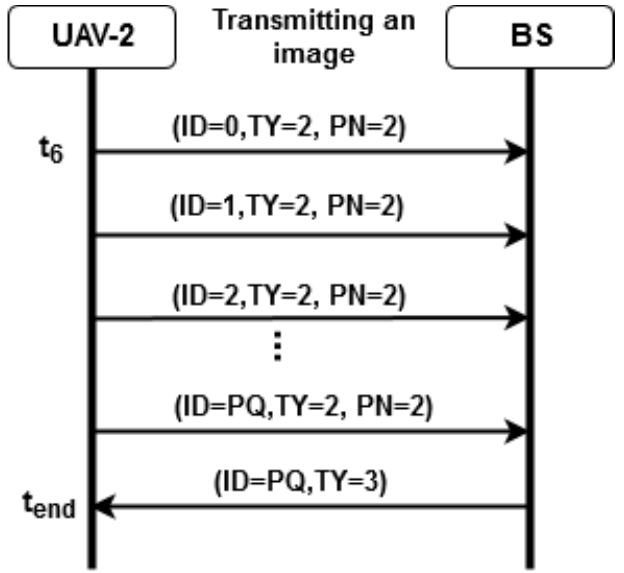
Figure 10. Message flow for transmitting an